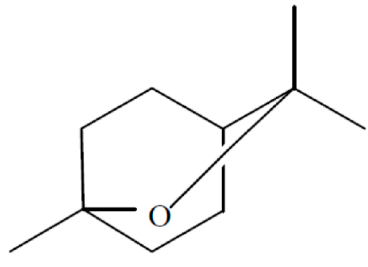
Figure 8. The structure of 1,8 cineole.